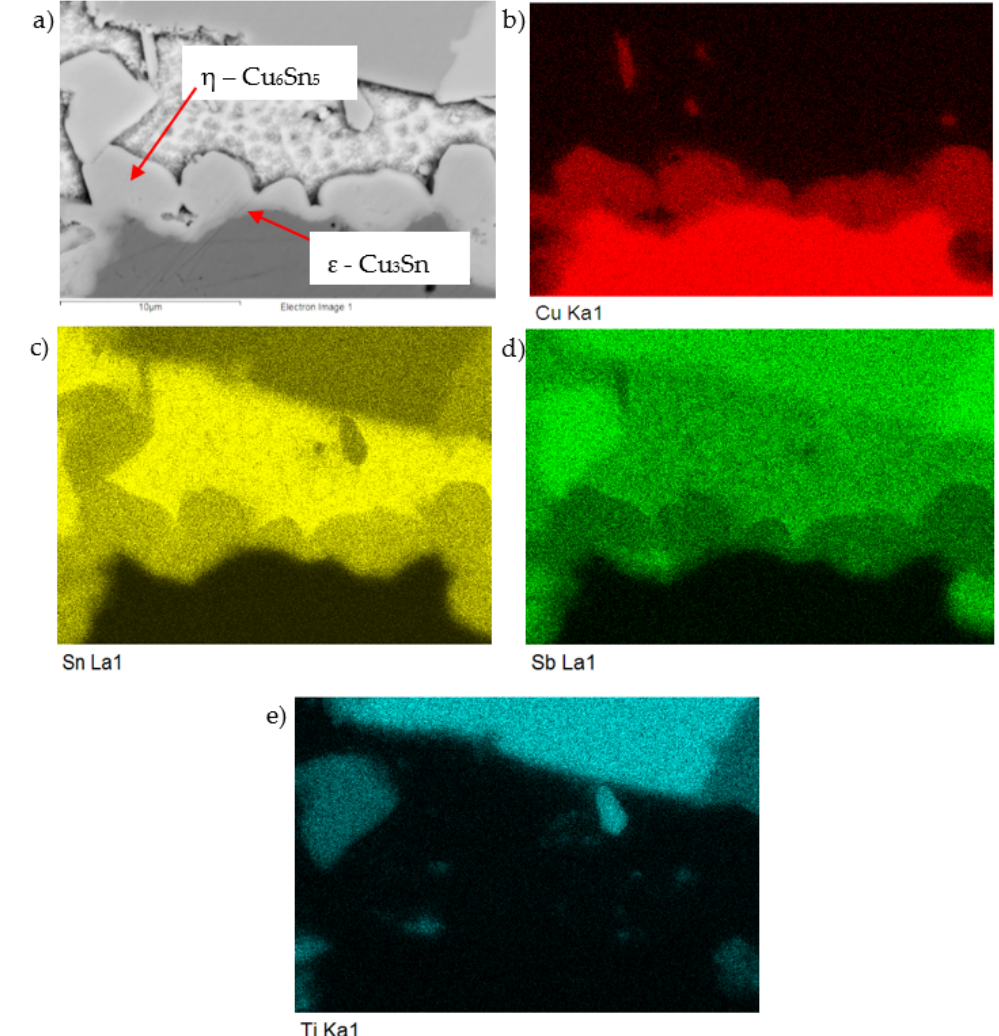
Figure 22. Map of elements in the boundary of the Cu–SiC/Sn5Sb3Ti joint; SEM photo of ( a ) the boundary, ( b ) Cu, ( c ) Sn, ( d ) Sb, and ( e ) Ti. The concentration profiles of Cu, Sn, Sb, and Ti elements (Figure 23) on the boundary of Cu–SiC/Sn5Sb3Ti joints have revealed the transition zone with the formation of the η - Cu 6 Sn 5 phase.